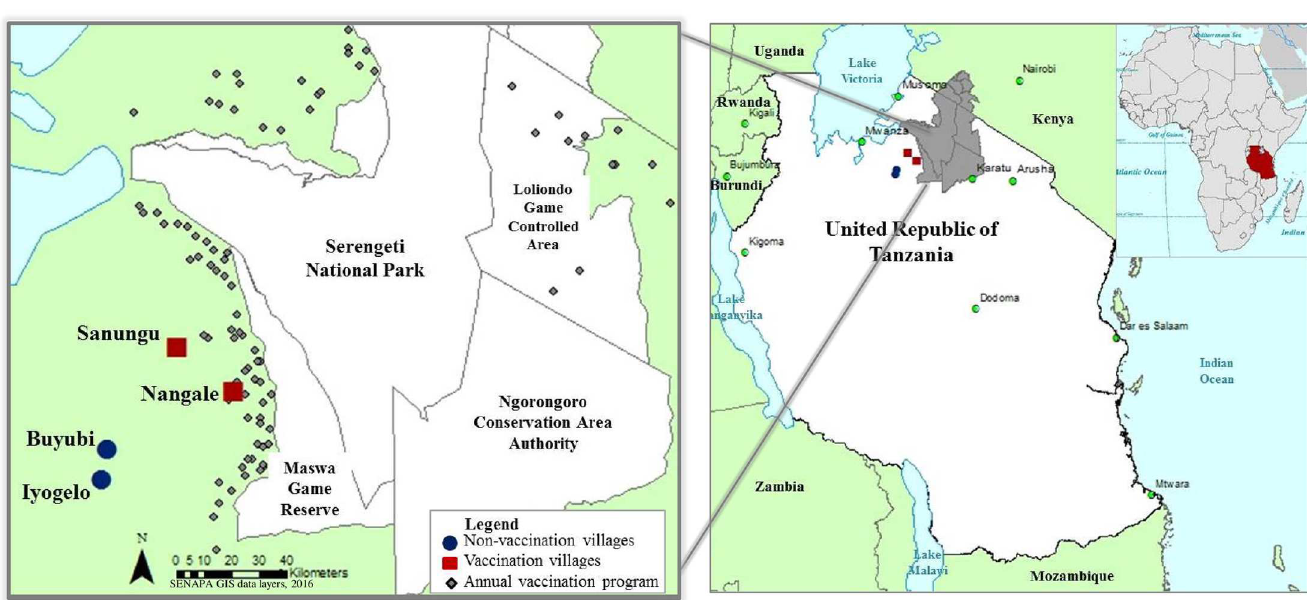
Fig 1. Location of study villages in relation to Serengeti National Park and existing dog rabies vaccination campaign. The locationof the four study villagesin relationto SerengetiNationalPark in Tanzania, East Africa is indicated.Nangaleand Sanunguvillages(red squares) are part of the existing vaccination programwhile Buyubiand Iyogelo (blue circles) are not part of the vaccinationprogramand therefore “control” villages.Grey lines definethe borders of SerengetiNationalPark and protectedareas (Maswa Game Reserve, Ngorongoro ConservationArea Authority, and Loliondo). Grey diamonds indicatethe locationof the villageswhere the annualdomesticdog vaccinationcampaignoccurredduringthis research[2,47,48].